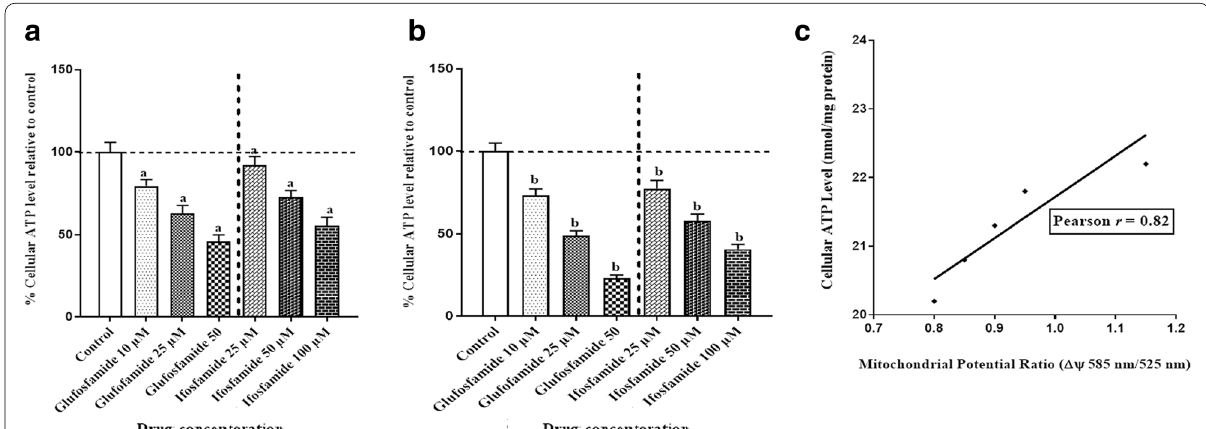
Fig. 7 Effects of glufosfamide and ifosfamide on ATP level in HepG2 cells. a Effects of glufosfamide or ifosfamide on ATP level in HepG2 cells following incubation for 48 h. b Effects of glufosfamide or ifosfamide on ATP level in HepG2 cells following incubation for 72 h. c Correlation between mitochondrial membrane potential and ATP level in HepG2 cells